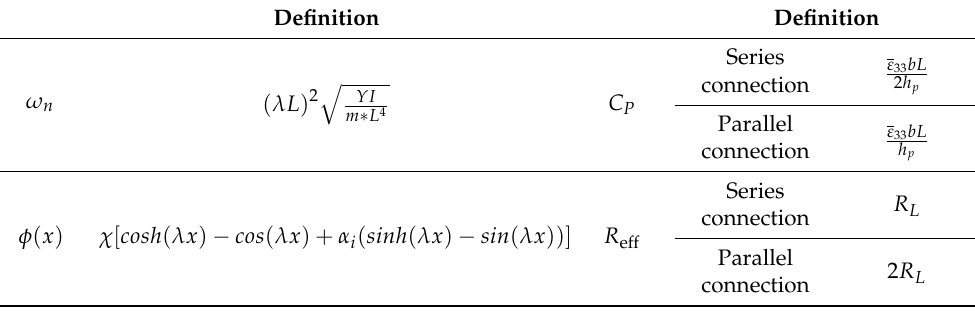
measured Figure 8. The motor’s supply voltage and rotation speed are linear relationships. Figure 9a shows a typical acceleration signal that is measured in the radius (R) direc- tion. The Fast Fourier Transform (FFT) can convert this acceleration into a frequency-do- main signal, see Figure 9b. The FFT represents a signal with a series of harmonic functions; therefore, the motor’s rotation speed and its higher multipliers exist in the FFT signal. In the FFT signal in the 5-to-55-Hz-span, two dominant frequencies can be seen, the first dominant frequency (1X) (the motor’s rotation speed) and the second dominant frequency (2X) (the second multiplier of the motor’s rotation speed). Accordingly, Figure 9b shows the FFT signals at all the rotation speeds in a frequency range containing the first (1X) and second rotation speeds (2X). The acceleration peaks for the 1X and 2X frequencies are shown in Figure 9c. The 2X’s peak amplitude is considerably higher than 1X’s, making the 2X frequency more appropriate for the piezoelectric harvester design. Linear fit